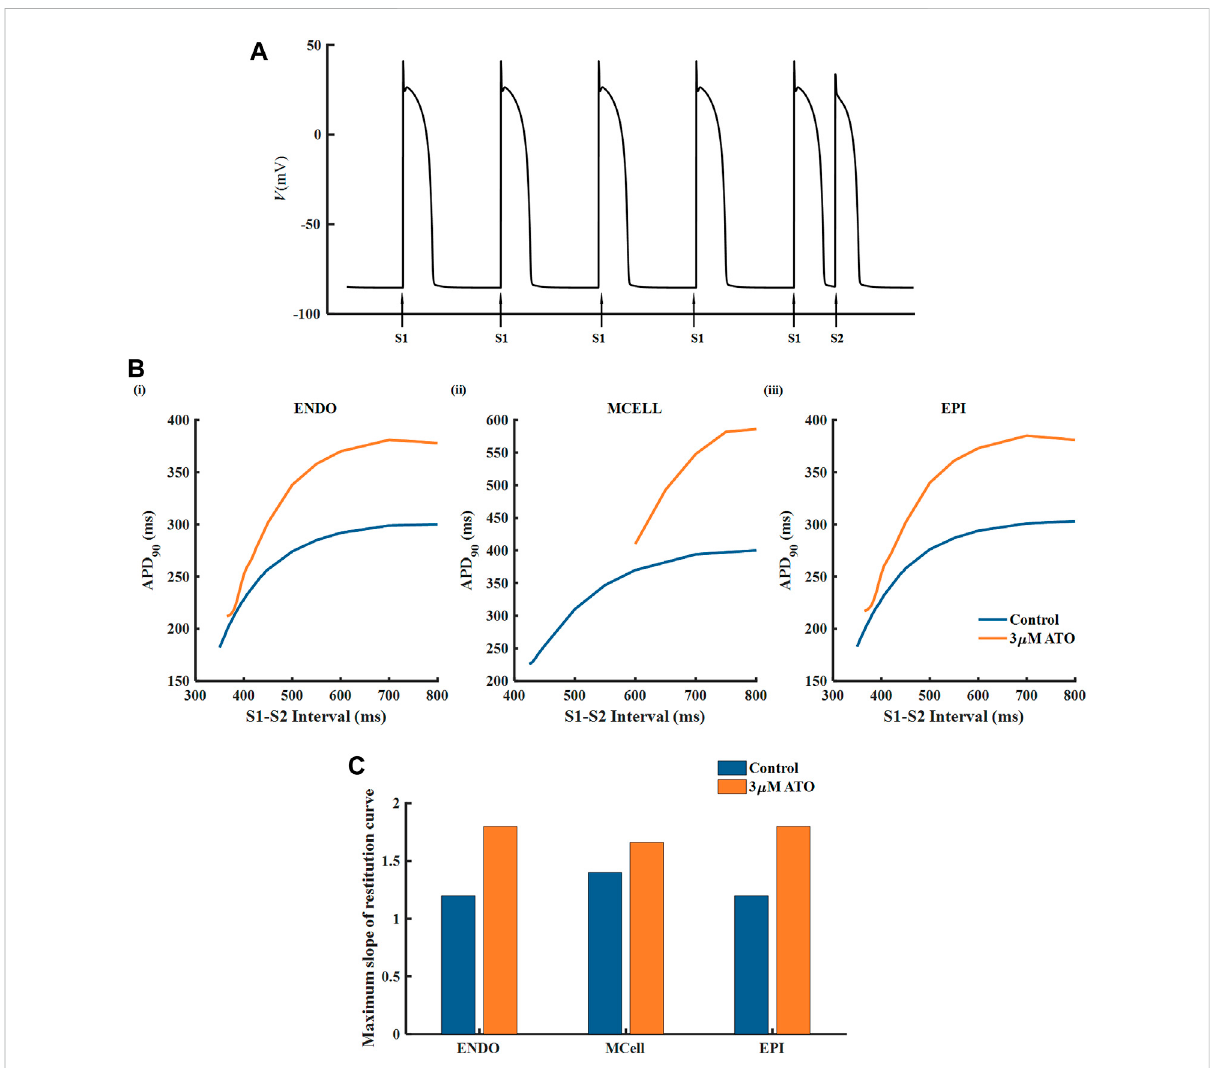
FIGURE 3 Therestitutioncurvesofventricularmyocytes. (A) TheS1-S2stimulationprotocol. (B) Therestitutioncurvesofendocardialcells(ENDO),middle cells (MCELL) and epicardial cells (EPI) on the condition of control and 3 μ M ATO. (C) The maximum slope of restitution curves in Figure (B)